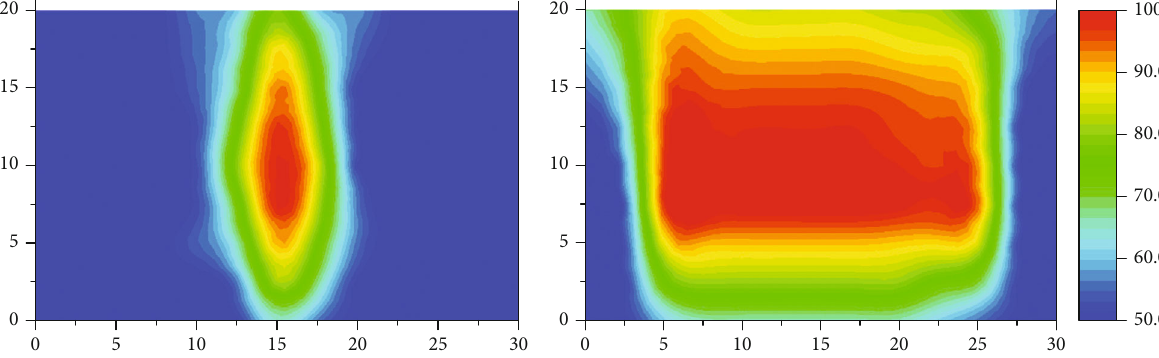
Figure 14: Temperature fi eld in the 3D model during the early stage of Experiment 3: (a) in the vertical direction of the wells and (b) along the